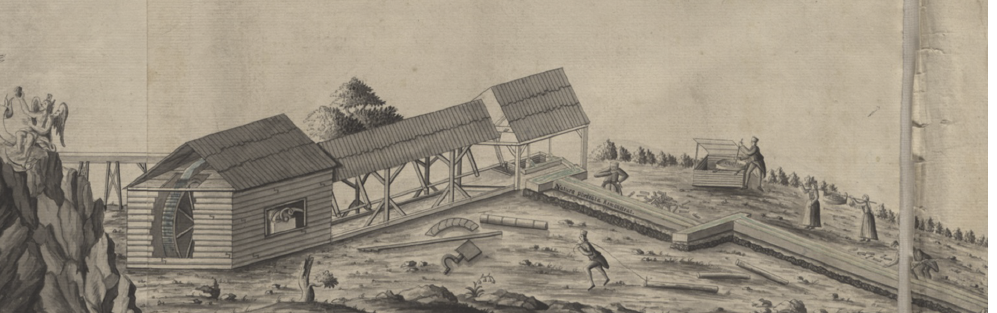
Figure 3. The first known depiction of the cementation process in Smolník on parergon of the General Map of Mining Works (1748) on the hill of Spitzen Berg (source: the State Central Mining Archives in Banská Štiavnica, Slovakia; photo was taken in 2016a).